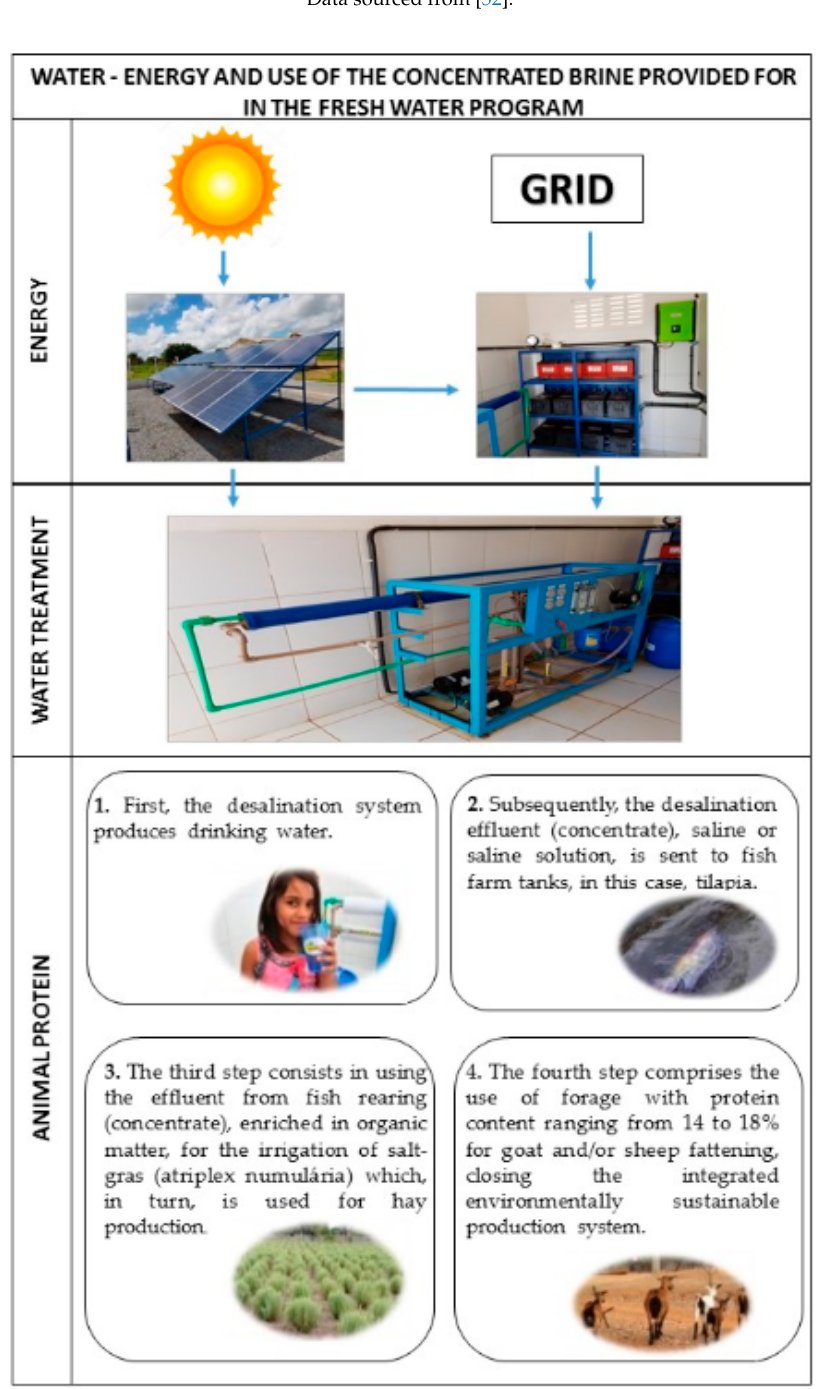
Figure 5. Illustration of the desalination system model operating with solar photovoltaic technology and integrated to a productive fish farming unit and irrigated forage. Table 5. Caatinga Grande settlement PAD productive system data for 2018.